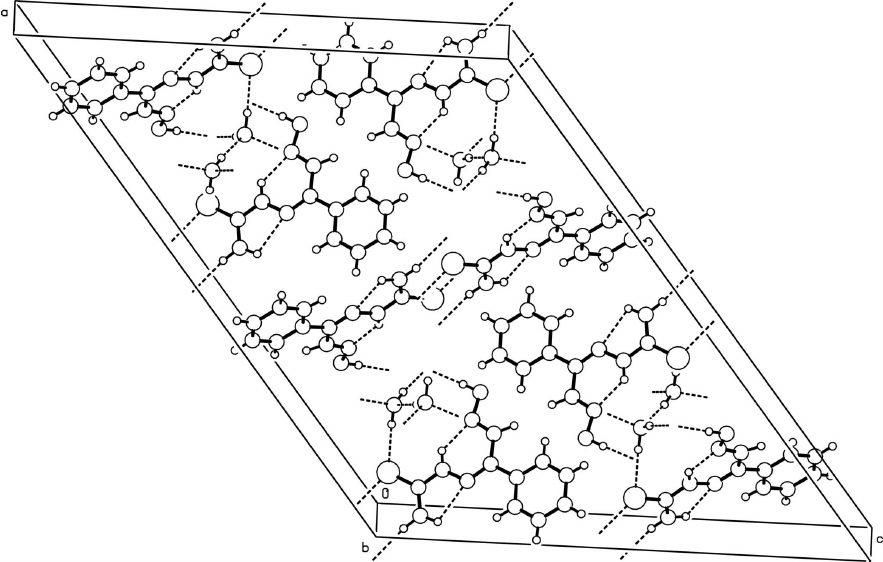
Figure 3 A partial packing diagram of (I). Hydrogen bonds are shown as dashed